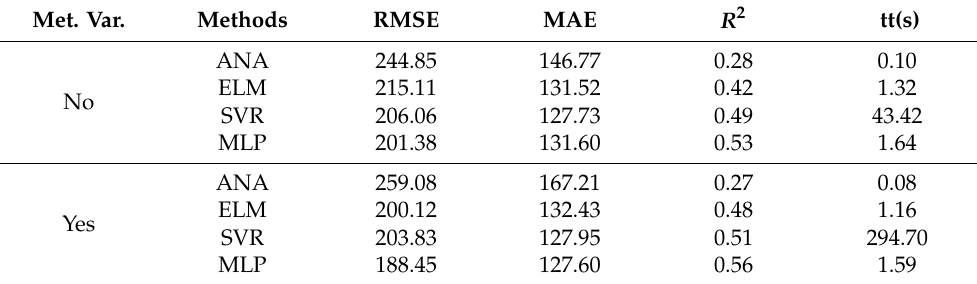
Table 9. Performance of the evaluated ML methods in the packet delivery dataset. Met.